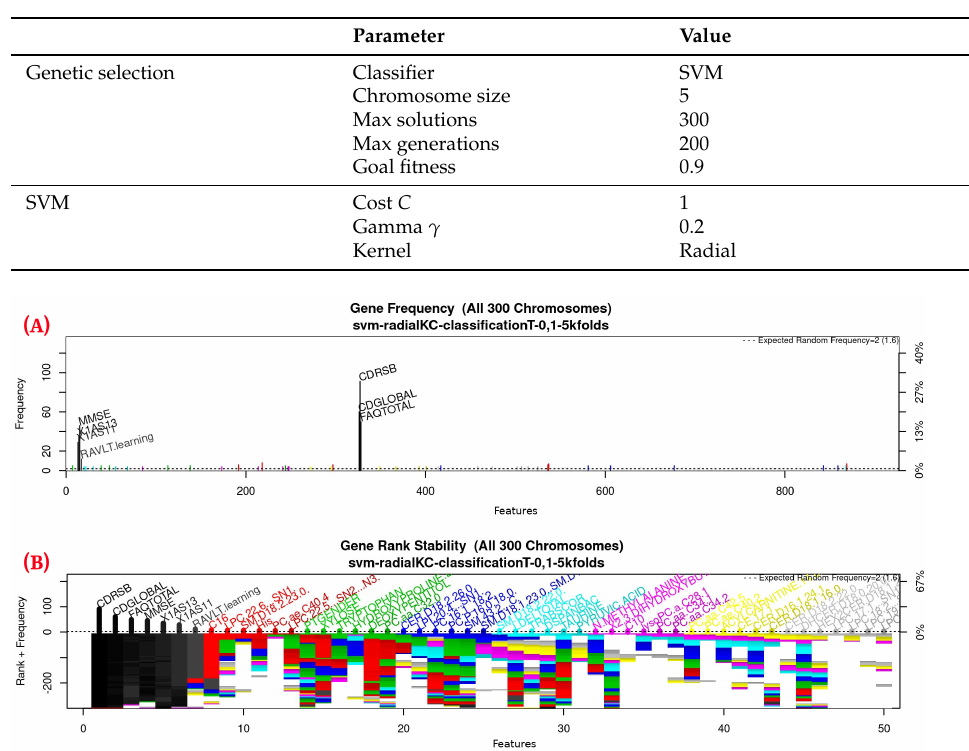
Table 3. GA input parameters. The genetic selection parameters are as follows: The chromosome size is set according to the recommendation found in Reference [34]. The number of solutions is defined to avoid bias. The number of generations is set to allow most of the models to converge (see Figure 4 or Figure A2 for a zoomed view). The goal fitness is defined to obtain a minimum performance required. The SVM hyper-parameters are as follows: The cost C is set to control the trade-off between decision and classification error and to avoid overfitting. A small γ value restricts the curvature of the decision boundary. A radial basis function is selected as the SVM kernel since it yields good out-of-box performance [38].